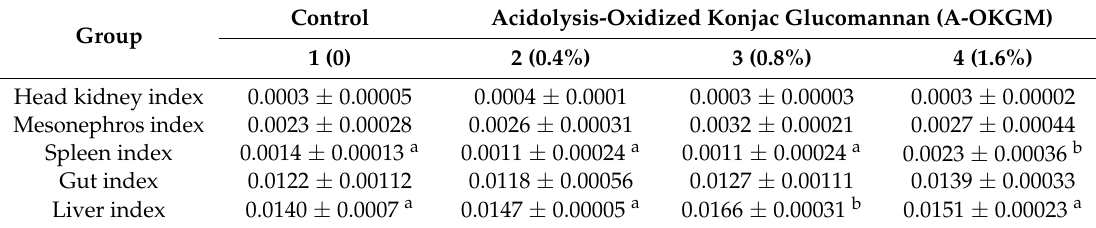
Table 1. Effect of A-OKGM on visceral index of S. prenanti